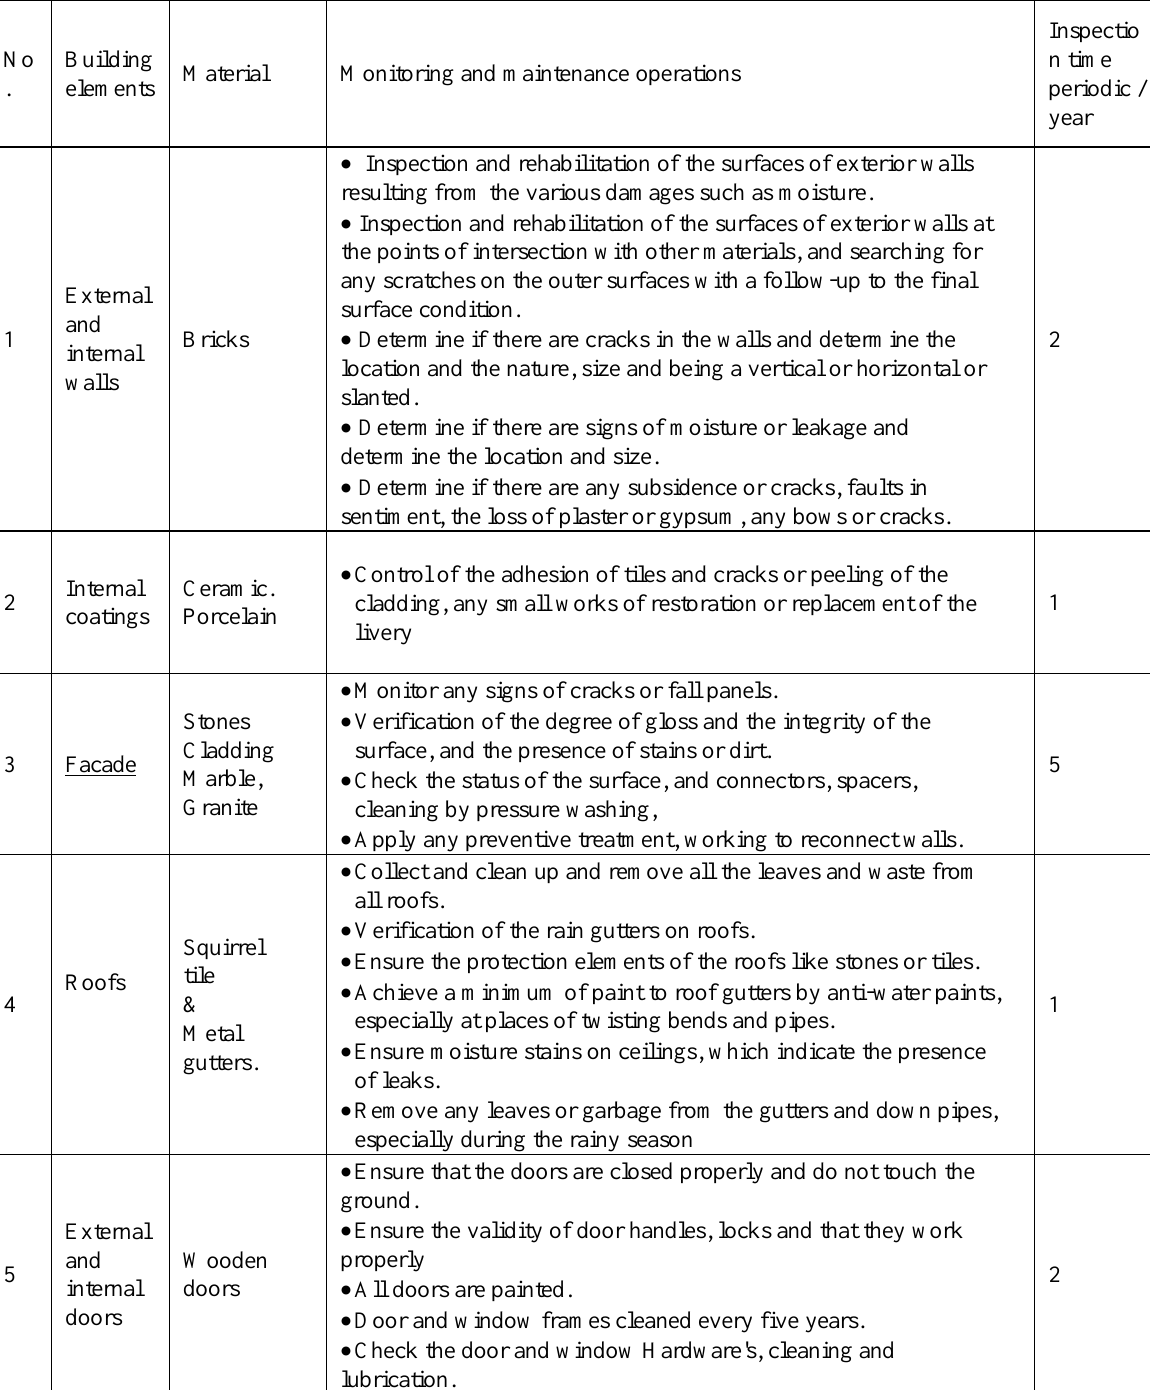
Table 4.Some of regular inspection activities and maintenance operations of the components of historical